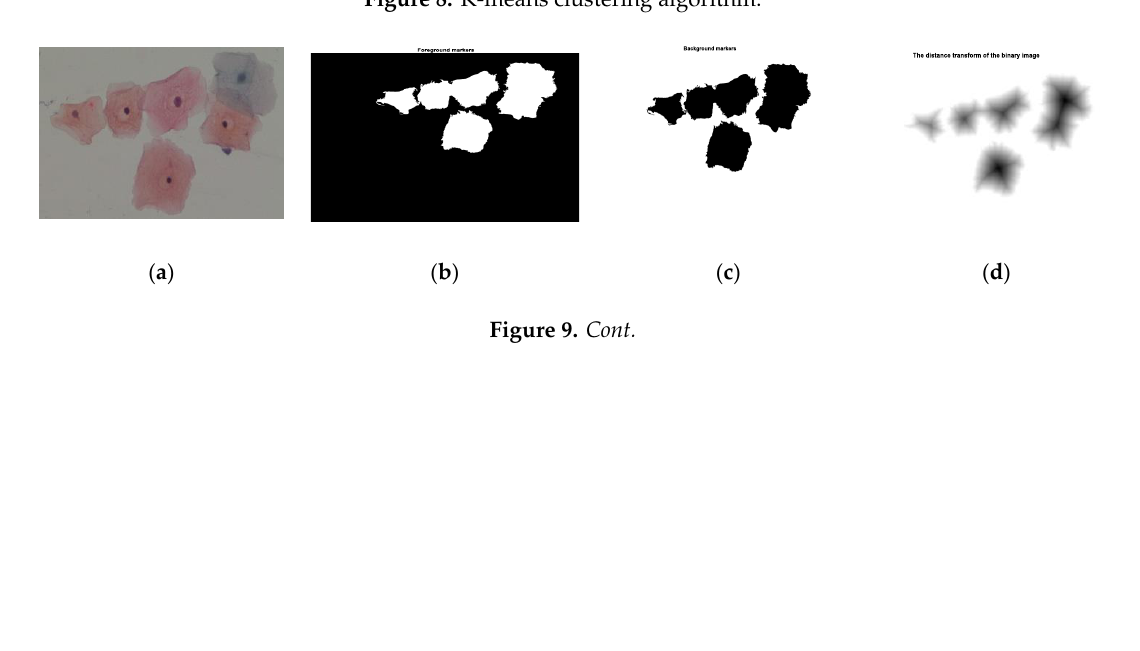
Figure 8. K-means clustering algorithm.